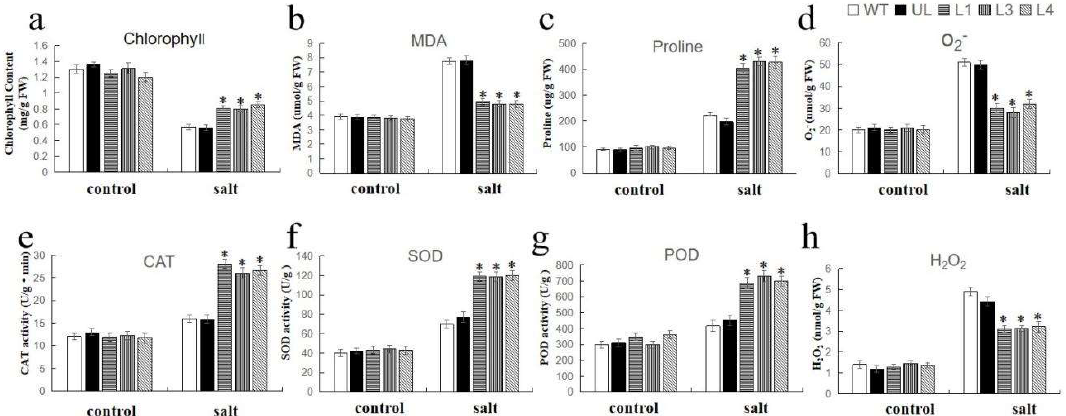
Figure 6. The physiological indicators of salt treatment on the WT, UL transgenic A. thaliana lines (L1, L3, and L4) overexpress FvMYB44 (200 mm NaCl treatment for 7 days). Chlorophyll ( a ), MDA ( b ), proline ( c ), O 2 − ( d ), and ( h ) hydrogen peroxide (H 2 O 2 ) content, and ( e ) CAT, ( f ) SOD, and ( g ) POD activity. The transgenic lines (L1, L3, and L4), the UL, and the WT are distinguished from each other by asterisks above each error bar. (* p ≤ 0.05). The index level of WT was used as the study control group.